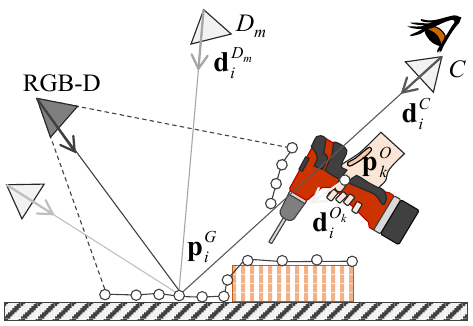
Figure 1. Illustration of setup.